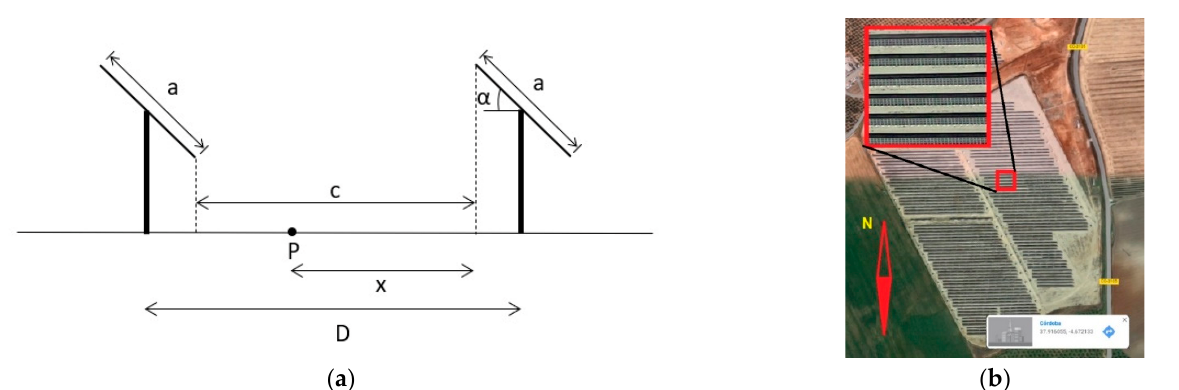
Figure 7. ( a ) Geometric variables considered to define the geometry of the type of PV plant under study; ( b ) aerial photograph of type of installation.